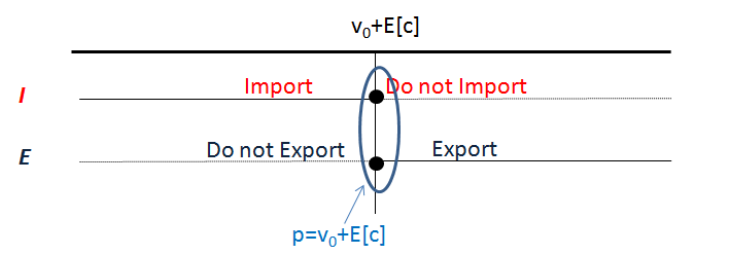
Figure 1. Absence of ambiguity: trade occurs exactly at the price p=v